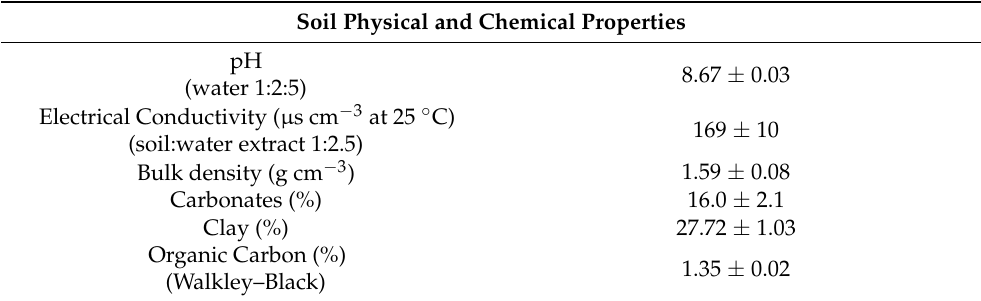
Table 1. Physical and chemical properties of the soil tilled layer (0–30 cm) for the control plots. Values are given as the mean ± standard deviation ( n =